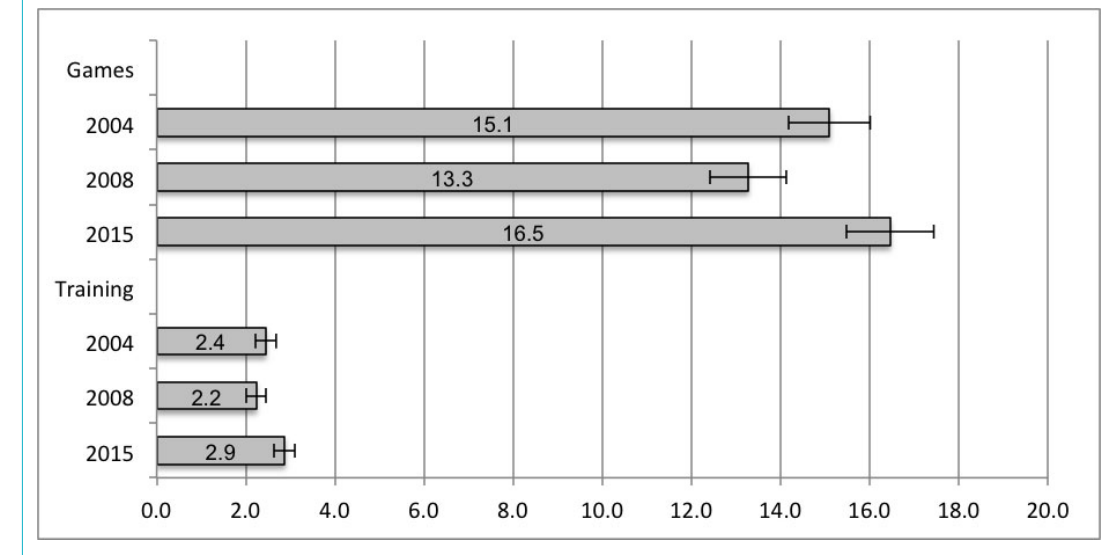
Figure 1: Injury incidence in amateur soccer per 1000 hours of playing during the previous 4 weeks (including 95% confidence intervals).